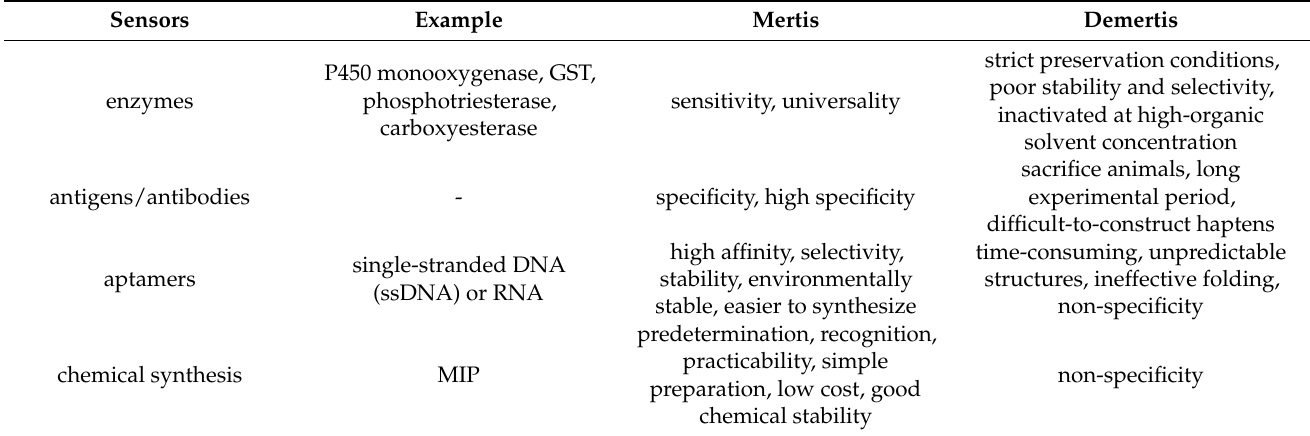
Table 2. The advantages and disadvantages of the recognition elements for the determination of